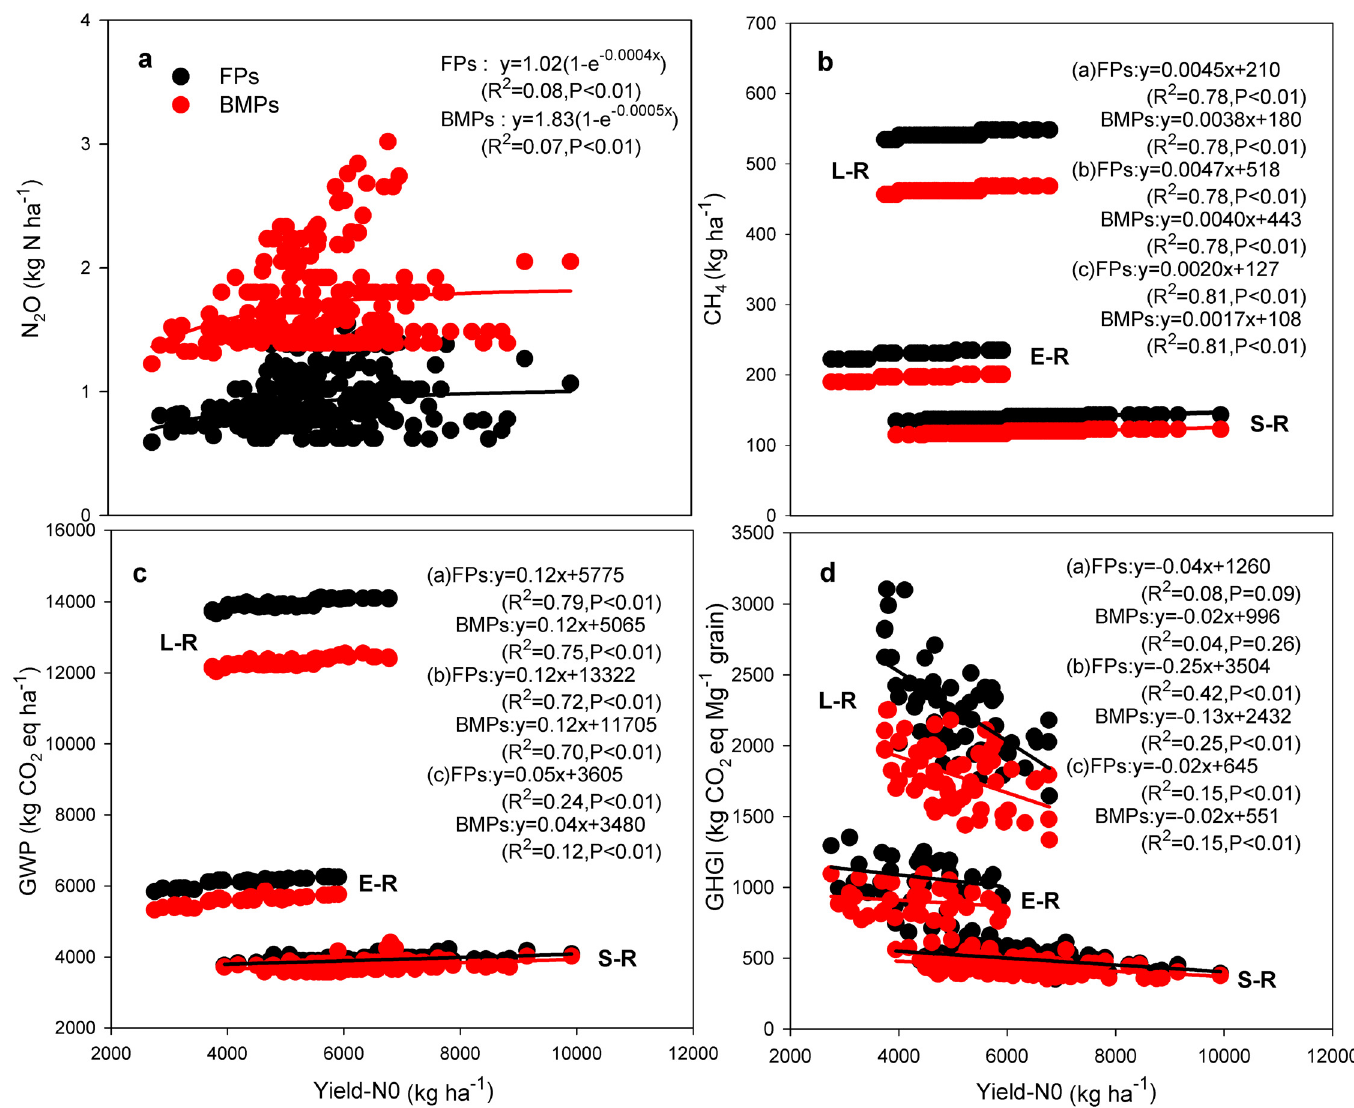
Fig 4. Relationships among management practices, soil inherent productivity and N 2 O emissions (a), CH 4 emissions (b), global warming potential (GWP, c), and greenhouse gas emission intensity (GHGI, d). Note: soil inherent productivity was estimated as yield in zero-N plots (Yield-N0). The GWP and GHGI is the sum of emissions of CO 2 -eq of N 2 O and CH 4 at area and yield scale during the rice growing season, respectively. Black points represent farming practice (FPs); red points represent best management practice (BMPs). For b, c and d, L-R, E-R and S-R represent late rice (n = 148), early rice (n = 98) and single rice (n =